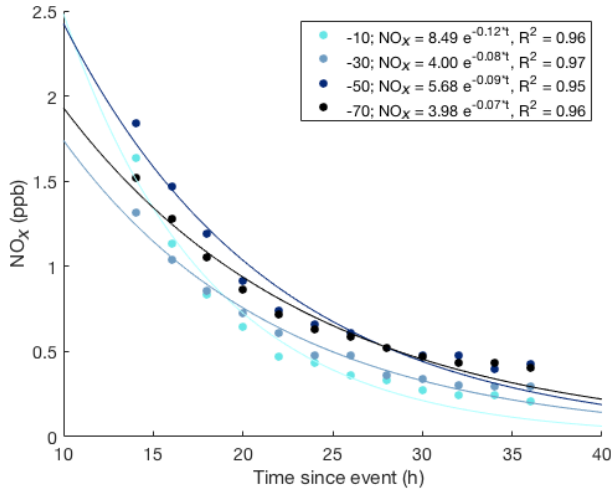
Figure 7. Exponential decay function fits to the NO x snowpack measurements versus time at four depths for the event starting on day of year 191 shown in Fig. 6. The start of the event was defined as the time when high NO x was detected above the snowpack. So- lutions for the best fit exponential decay functions are given in the legend.